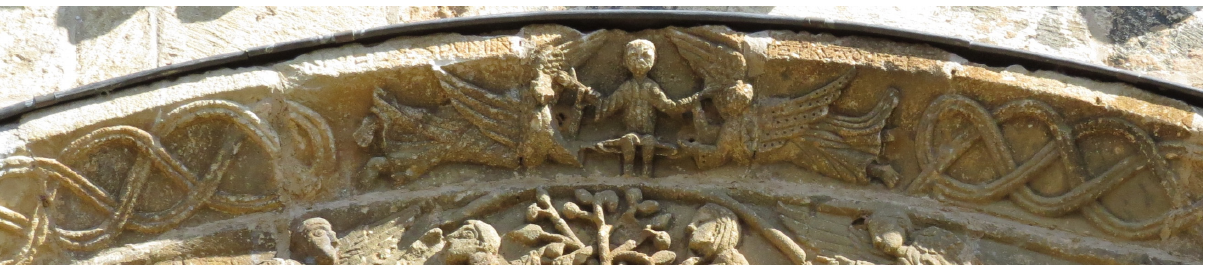
Figure 3. Archivolt, detail of west façade, Saint-Martin Church , 12th c., Besse, Dordogne, Nouvelle- Aquitaine, France. ©Author.